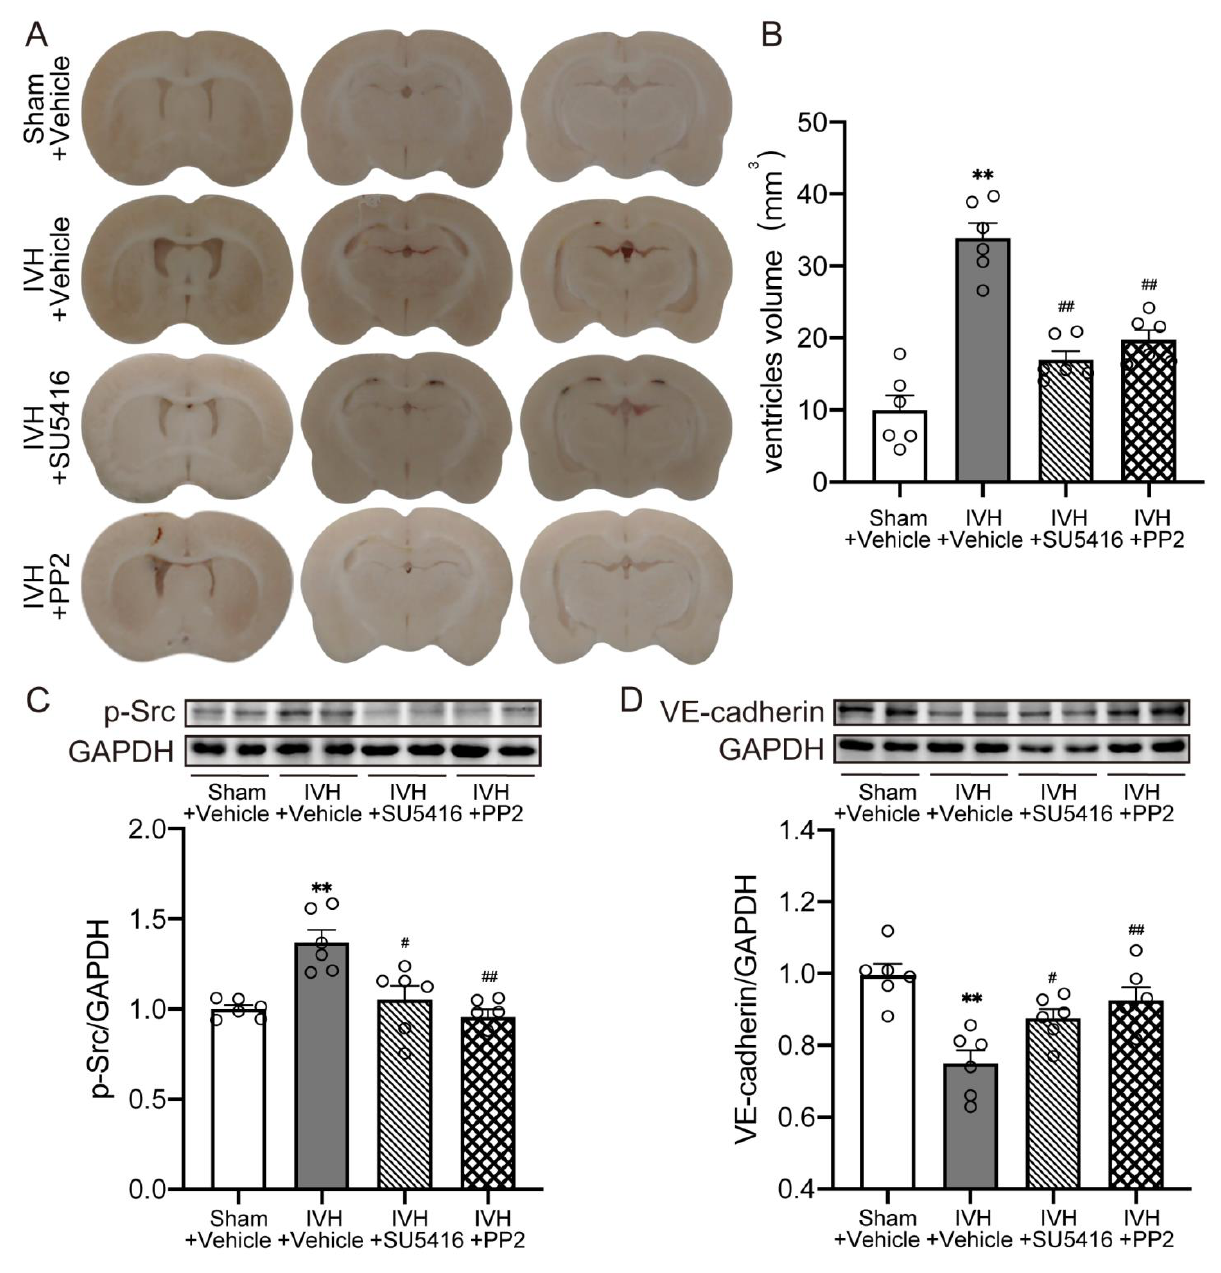
Figure 5. Inhibition of VEGFR2/p-Src attenuated IVH-induced hydrocephalus and increased the level of VE – cadherin ( A ) Frozen coronal brain sections at 7 days after injection of 200 μL of saline or blood into the right lateral ventricle with a treatment of vehicle/SU5416/PP2. ( B ) Quantification of lateral ventricle volume from section images, n = 6. ( C ) p-Src expression level was assessed by western blot, n = 6. ( D ) VE – cadherin expression level was assessed by western blot, n = 6. Data were analyzed by one-way ANOVA with a Tukey ’ s post hoc test. Values are means ± SEM, ** p < 0.01 vs. Sham, # p < 0.05 vs. IVH + Vehicle, ## p < 0.01 vs. IVH + Vehicle.